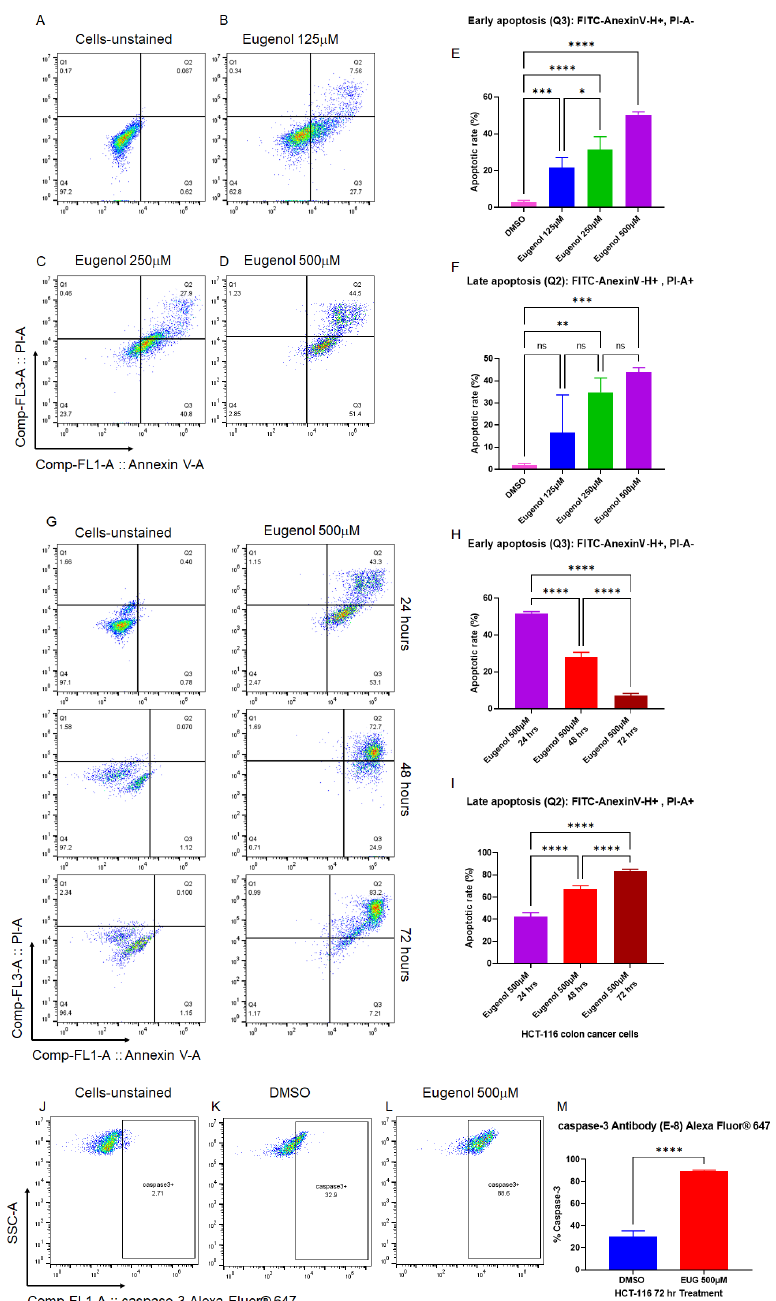
Figure 2. EUG induces apoptosis in colon cancer cells in a dose- and time-dependent manner. Panels ( A – F ): HCT-116 colon cancer cells were incubated with DMSO or EUG (125, 250, and 500 µ M) for 24 h, followed by PI/annexin V flow cytometry analysis. Panels ( G – I ): HCT-116 cells were subjected to EUG 500 µ M treatment for 24, 48, and 72 h followed by PI/annexin V flow cytometry analysis. Collected flow cytometry results were analyzed with FlowJo software to determine the % of Annexin V-positive (early apoptosis) versus Annexin V/PI-positive cell populations in the presence and absence of EUG. Annexin V-positive—PI-negative populations represent cells with an intact membrane (early apoptosis), while Annexin V-positive—PI-positive staining indicates cells with compromised membranes (late apoptosis). Cells in late apoptosis act like necrotic cells. Graphical representation of FlowJo results in early and late apoptosis performed and expressed as the mean ± standard deviation. Panels ( J – M ): Cancer cells positively stained with caspase-3 Antibody-Alexa Fluor 647 show EUG significantly increases caspase-3, a principal marker of apoptosis. Four independent experiments were carried out in triplicate ( p -value * < 0.05, ** < 0.01, *** < 0.001, **** < 0.0001). ns—non